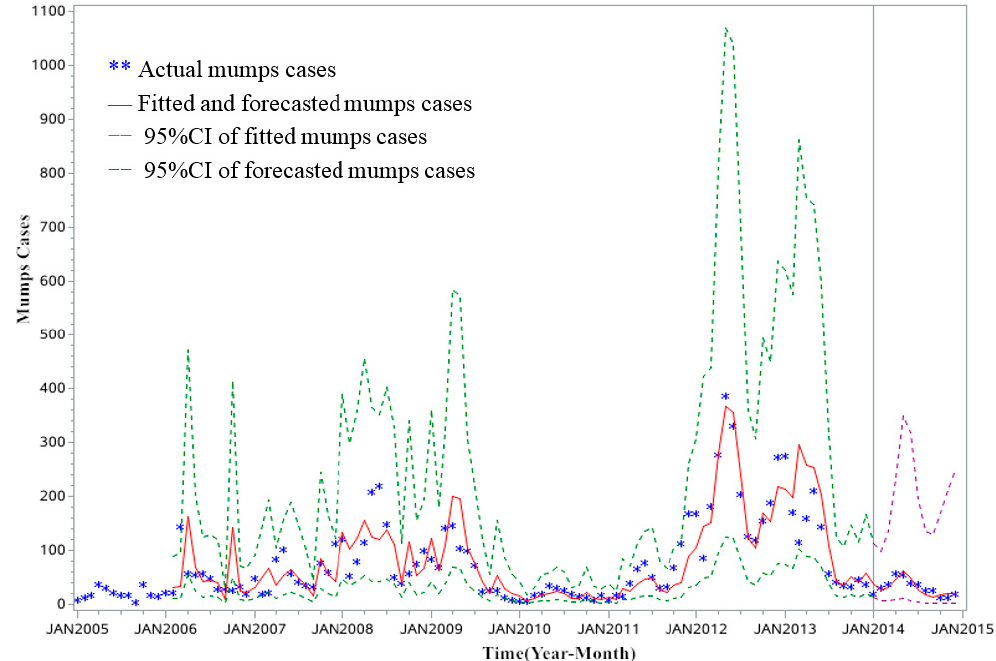
Figure 8. Fitted and forecasted results of monthly cases of mumps in Zibo City (the actual data are contained within the 95% CI of the forecasted value).